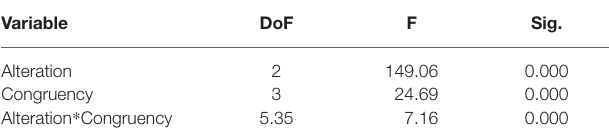
TABLE 3 | ANOVA results for percentage of correct answers. Variable DoF F